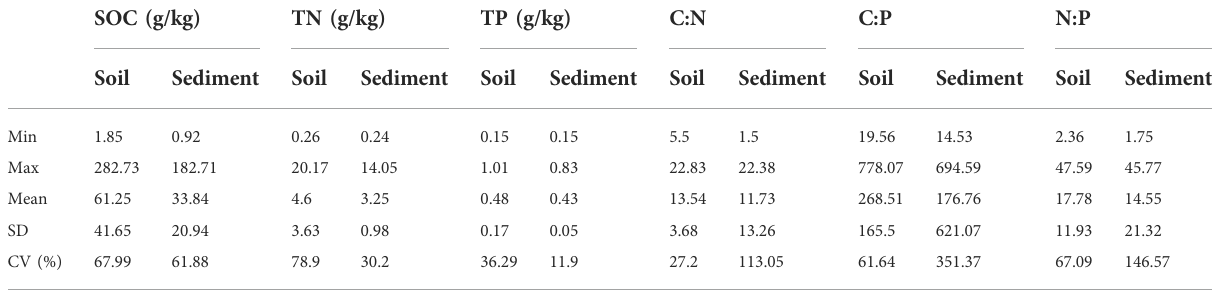
TABLE 1 Basic information of C, N, P concentrations and stoichiometric ratios. The stoichiometric ratios were calculated on a molar basis. The number of samples is 44.